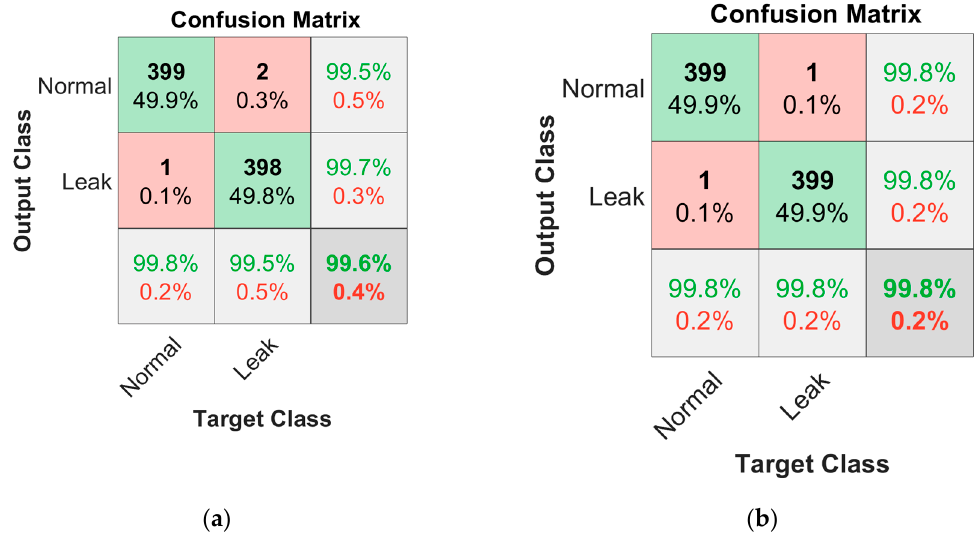
Figure 8. Confusion matrix of the one-dimensional convolution neural network (1D-CNN) classification results when the frequency spectrum input had ( a ) a signal with the impulse and ( b ) a signal where the impulse was removed.